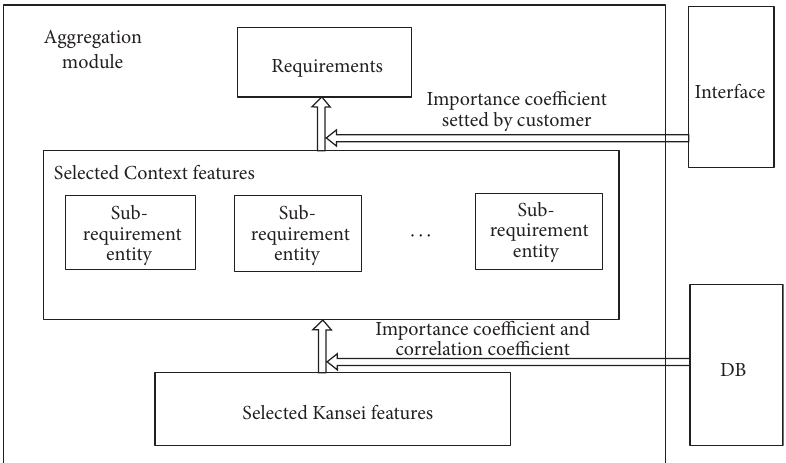
Figure 4: Multiattribute aggregation